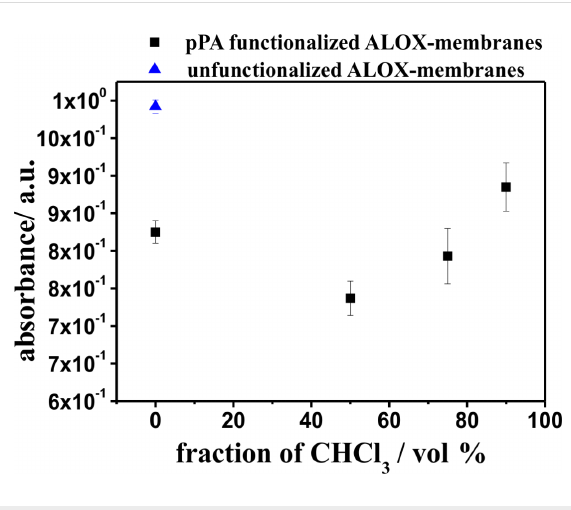
Figure 12: Absorbance values of the water fractions with chloroanilic acid after the loading